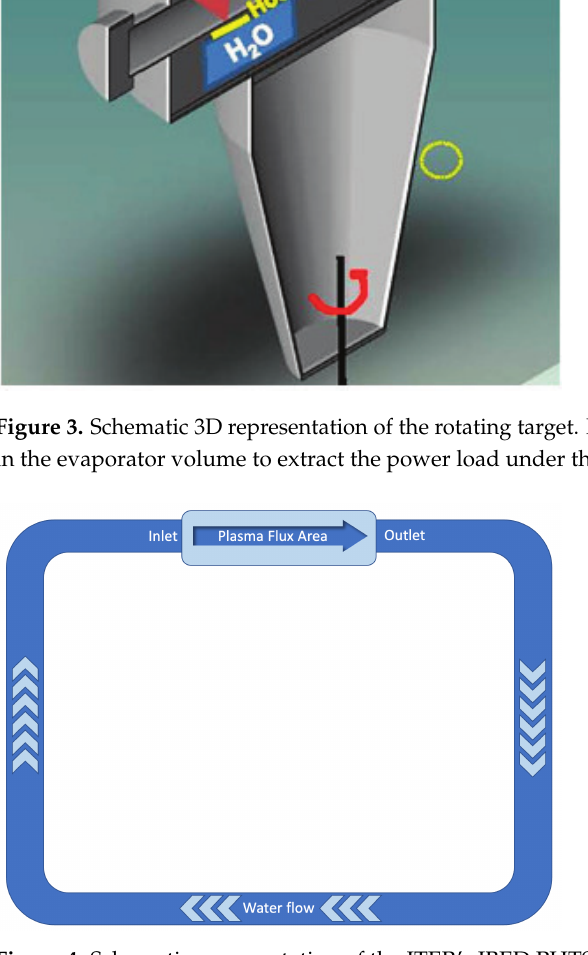
Figure 4. Schematic representation of the ITER’s IBED PHTS. Data from